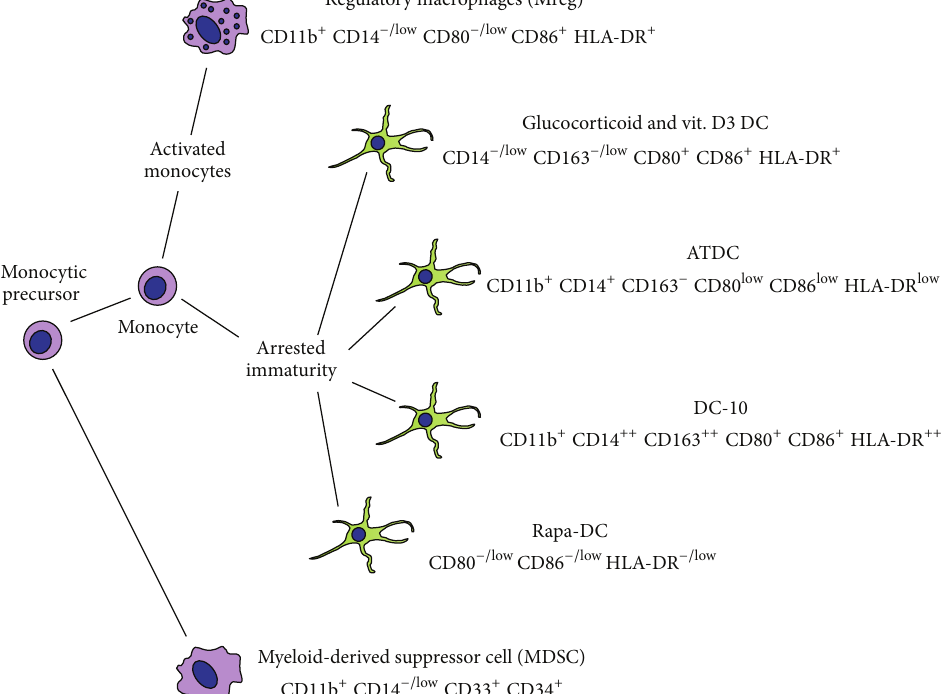
Figure 3: tolAPC types being developed as immunosuppressive cell-based medicinal products. The spectrum of myeloid regulatory cell products currently being developed as medicinal products is diverse, so it is valuable to categorise them as cells in arrested states of immaturity (tolDC), activation-induced suppressor cells, or myeloid-derived suppressor cells. Examples of different tolDC products are